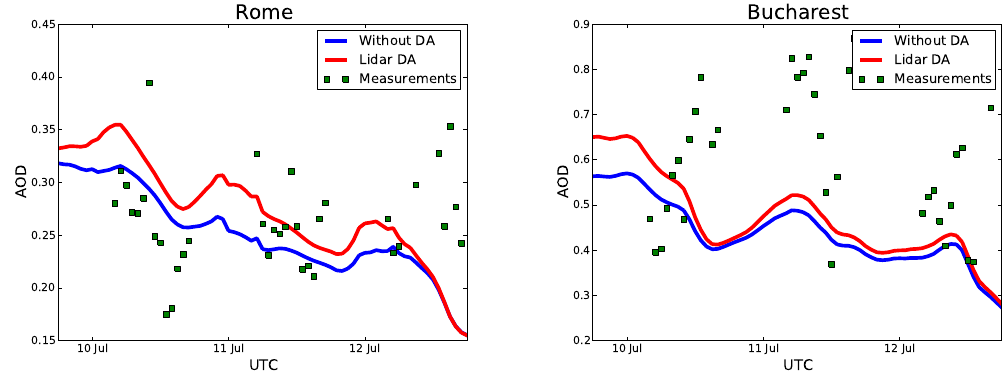
Figure 13. Time evolution of the hourly-averaged measured AODs (green dots) and simulated AODs without DA (blue lines) and with DA (red lines) over the first 36-h forecast period, at the AERONET stations of Rome and Bucharest. As discussed in Sect. 4, the “DA L h = 100 km” DA test, which assimilates lidar signals retrieved from the lidar campaign from 1.0 to 3.5 km a . g . l . during 12 h with L h